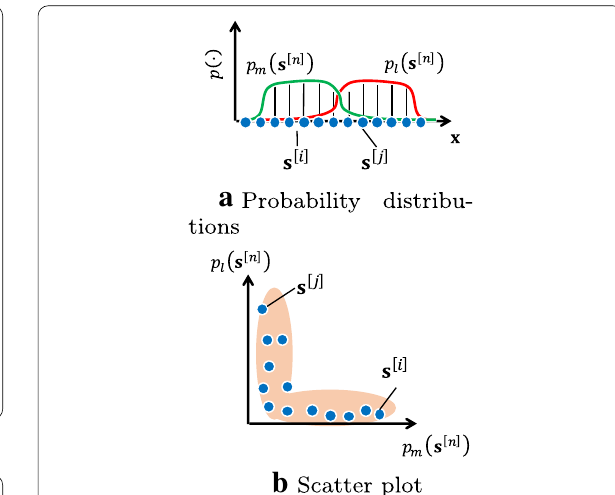
Fig. 3 Negatively correlated probability distributions